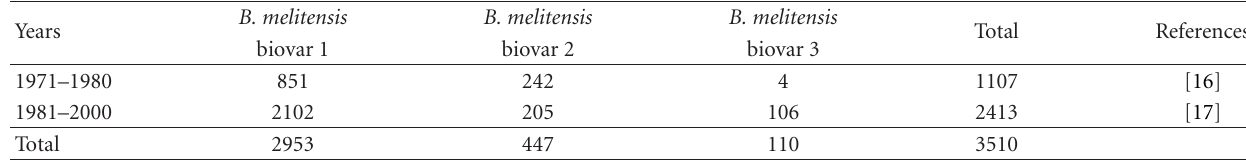
Table 2: Frequency of di ff erent B. melitensis biovars isolated in